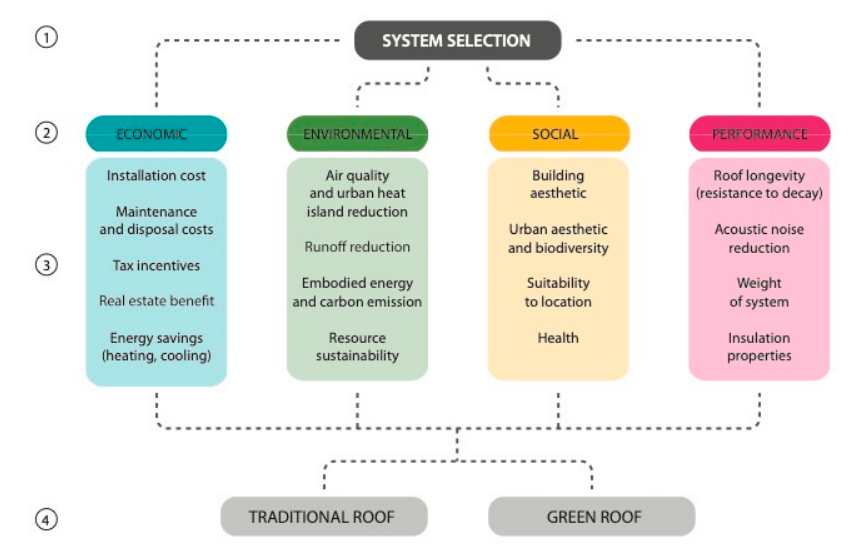
Figure 2. Hierarchy structure.